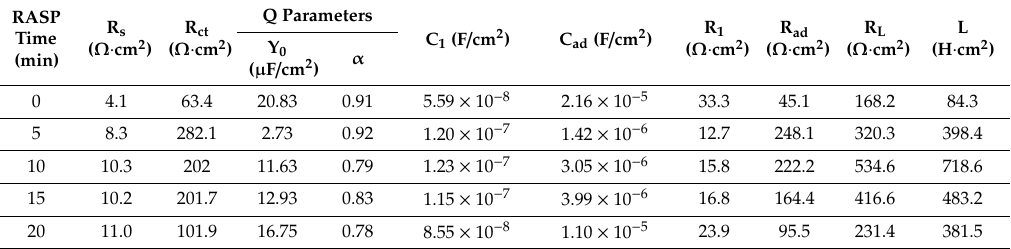
Figure 8. The fitted electrochemical impedance spectroscopy (EIS) of original specimen after potentiostatic polarization in the 0.2 M NaCl + 0.05 M Na 2 SO 4 solution: ( a ) Nyquist plots and ( b ) Bode plots. The inset of ( a ) shows the equivalent electrical circuit for the specimen. Table 4. Equivalent-circuit element values for EIS data corresponding to the SA106B low-carbon steel treated for di ff erent times in 0.05 M H 2 SO 4 + 0.05 M Na 2 SO 4